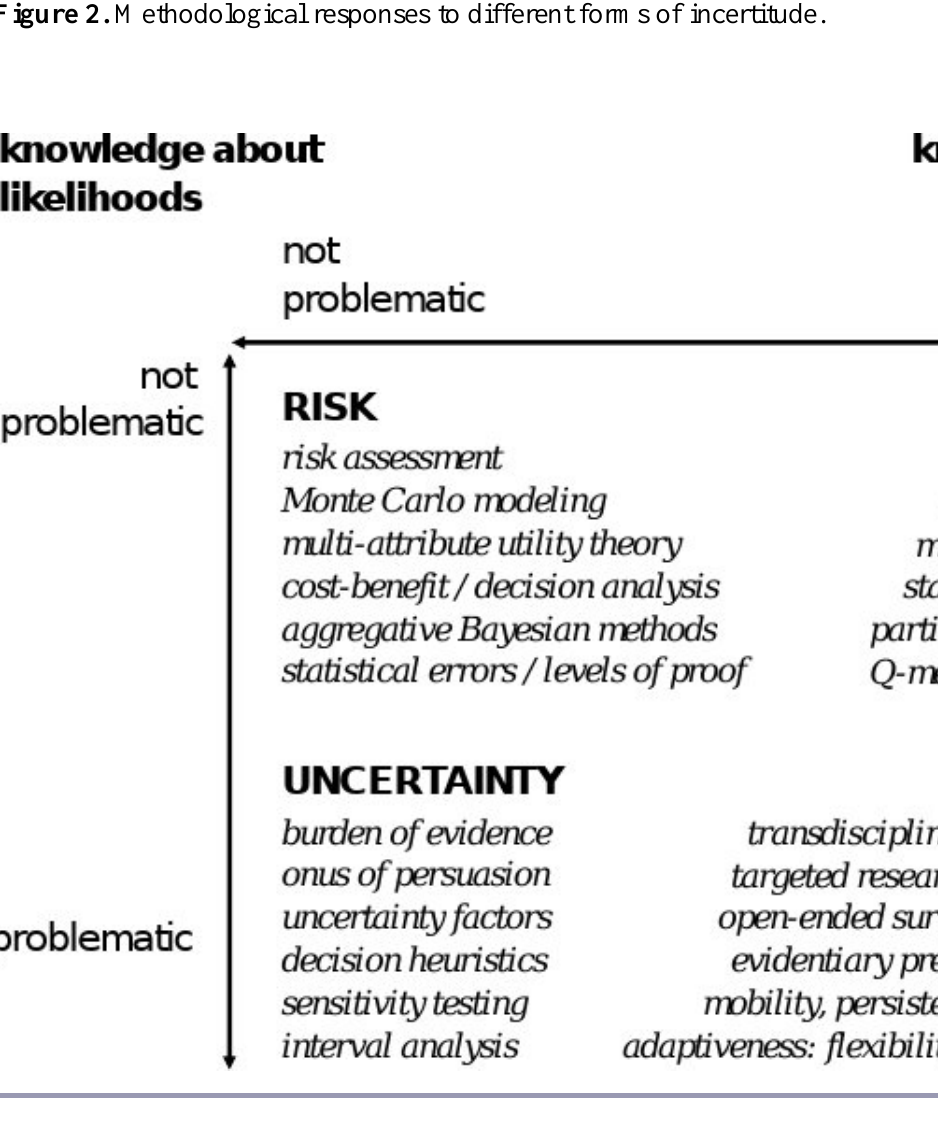
Figure 2. Methodological responses to different forms of